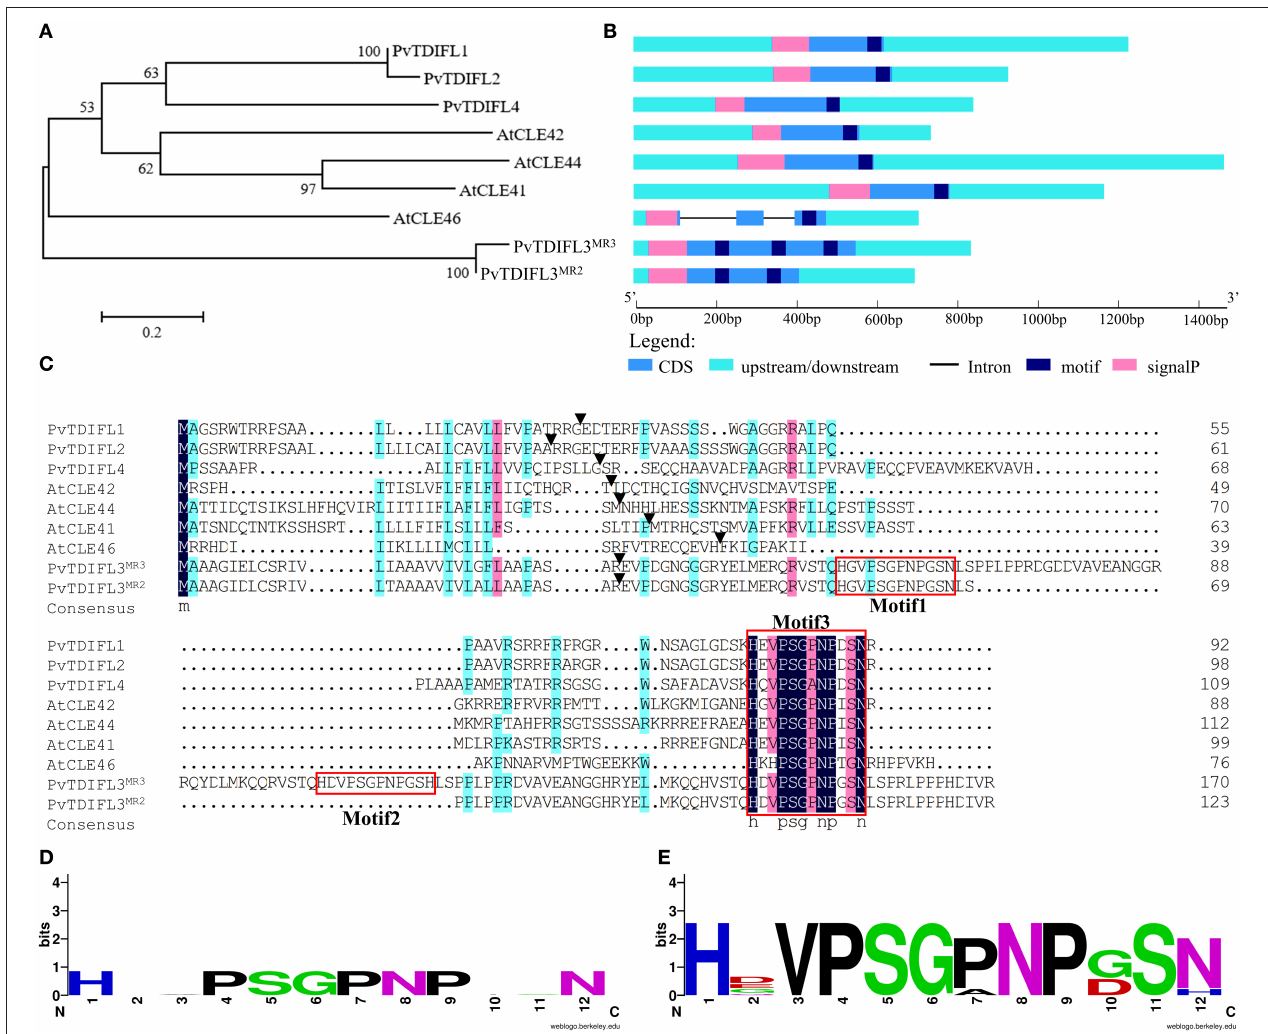
FIGURE 2 | Phylogenetic analysis and genomic organization of tracheary element differentiation inhibitory factor (TDIF) in P. virgatum and A. thaliana . (A) Phylogeny of full-length protein sequences from PvTDIFLs and AtTDIF. The alignment was generated by using Muscle with the Maximum Likelihood method and 1,000 bootstrap iterations. Numbers on the nodes indicate clade credibility values. (B) Gene structures of PvTDIFLs and AtTDIF from nucleotide sequences. Gene structure analysis was performed using the gene structure display server 2.0. Cyan box, 3 ′ UTR and 5 ′ UTR; blue box, CDS; pink box, signal peptide; navy-blue box, TDIF peptide; black line, intron. (C) Multiple amino acid sequence alignment of PvTDIFL and AtTDIF proteins. Multiple alignments were performed using the DNAMAN v6.0 software. TDIF peptides are boxed in red. Black triangles indicate the SignalP cleavage site. (D,E) Weblogo images of AtTDIF (D) and PvTDIFL (E) . The images were created by using the Weblogo online tool with the amino acid sequences from AtTDIF and PvTDIFL peptides,